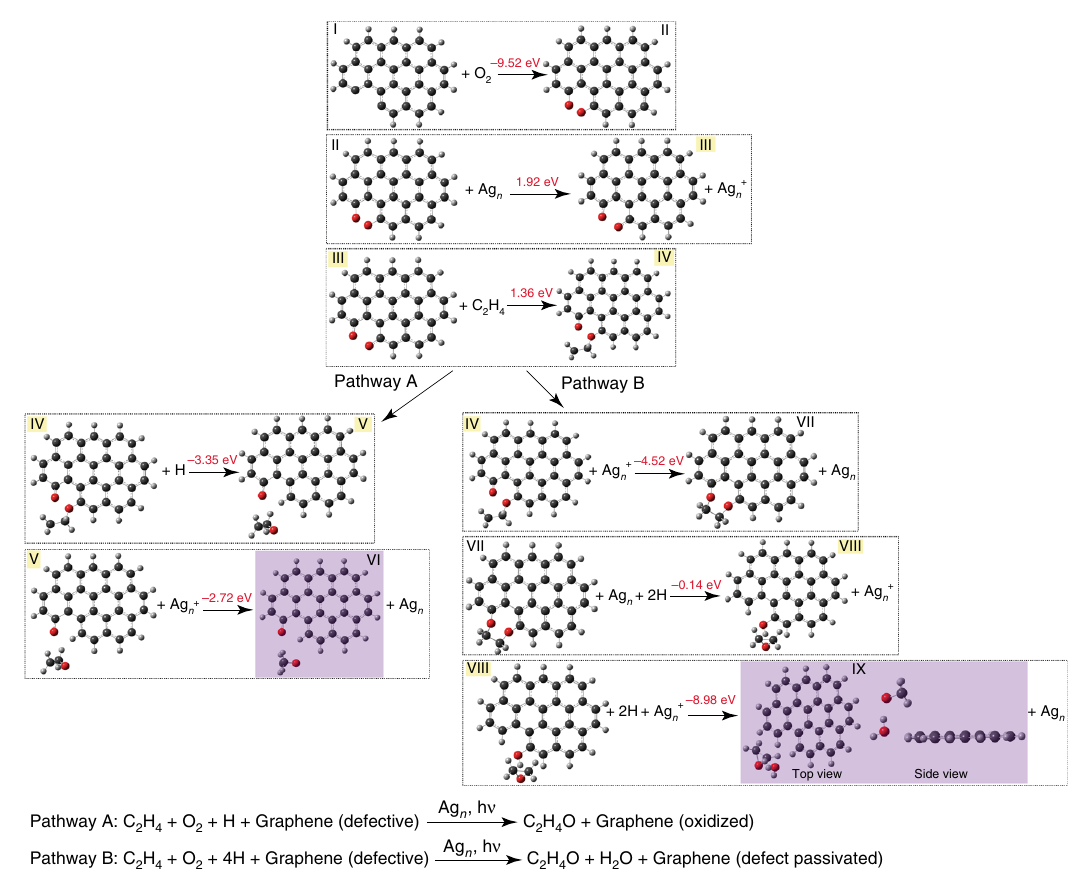
Fig. 4 DFT simulation of the role of graphene nanofragments in catalysis. Two possible reaction pathways by which unterminated bonds of graphene nanofragments can participate in C 2 H 4 epoxidation. Here and in molecular geometries in the Supplementary Information, O atoms are shown in red, C atoms in dark gray, and H atoms in light gray. Ag n refers to the 15-atom Ag cluster model employed in DFT simulations. The arrow within each step signi fi es that a geometry optimization of the chemical species on the left leads to the species on the right. The product of each reaction pathway is shown by purple shading. Free energies for each elementary step are shown (atop each arrow), which were calculated from optimized geometries of gas phase species (I – IX) involved in each step. The species highlighted in yellow were assigned a − 1 charge, to simulate the injection of a hot electron from Ag. The overall reaction for each pathway is shown at the